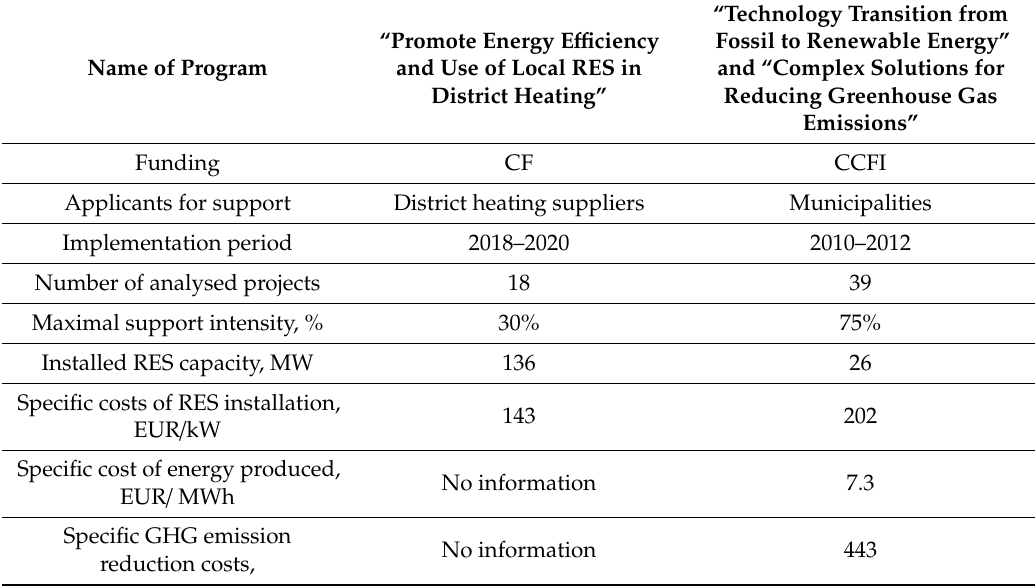
Table 1. Overview on RES policy